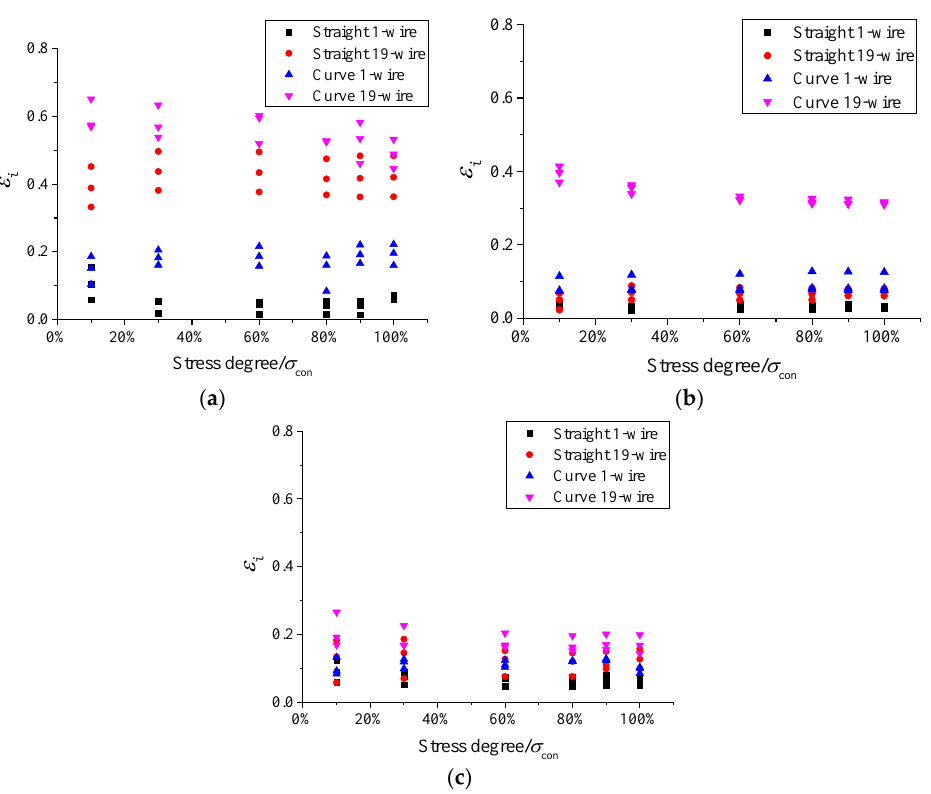
Figure 13. Instantaneous ε i at each stress degree: ( a ) rubber hose; ( b ) metal bellow; and ( c ) plastic bellow. Table 6. Measured pre-stress loss.